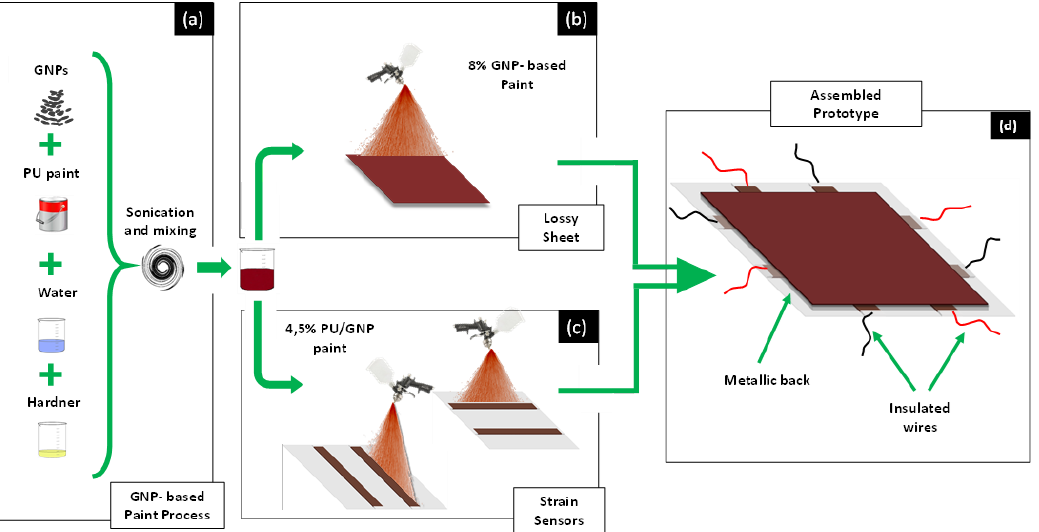
Figure 1. Schematic representation of the fabrication steps of the sensorized radar-absorbing structure: ( a ) production of the paints loaded at different weight concentrations of GNPs; ( b ) realization of the lossy sheet; ( c ) realization of the strain sensor array; ( d ) final assembled structure.